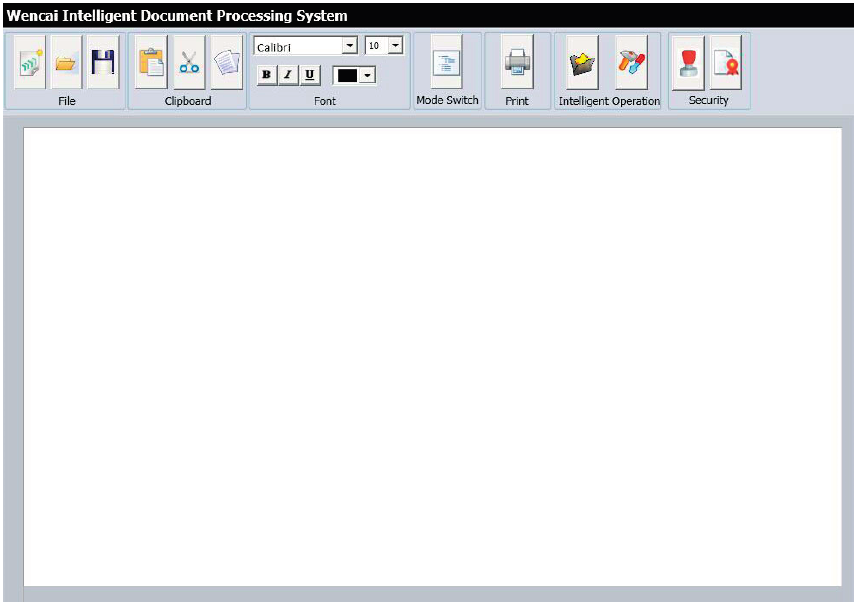
Figure 6. The initial view for browsing documents.